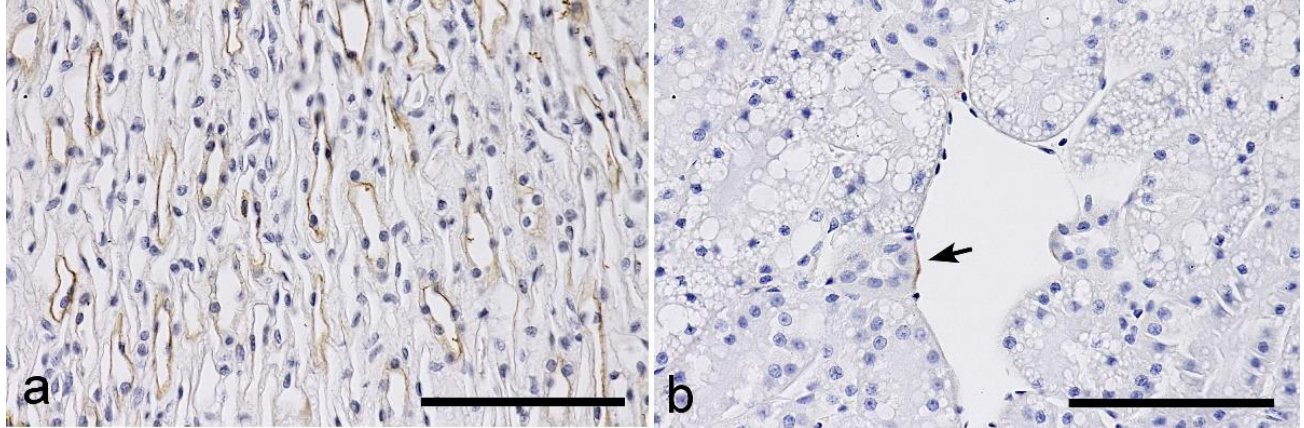
Figure 7. Histochemical staining for Soybean agglutinin (SBA) and Dolichos biflorus agglutinin (DBA) in the feline kidney. ( a ) SBA: inner medulla. Positive labeling can be observed in the thin limbs of the loops of Henle. ( b ) DBA: superficial area of the cortex. Positive labeling can be regionally observed in the vascular endothelium of a capsular vein (arrow). Scale bars: 100 μm.